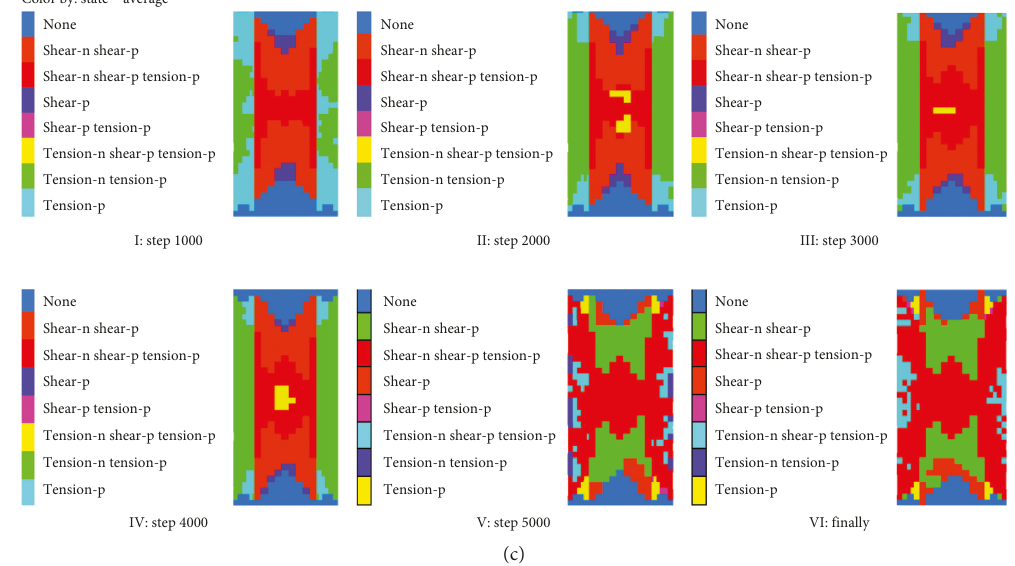
Figure 8: Numerical simulation contour of the loading process of RCTMC specimen. (a) Z -directional stress contour through the point (0, 0, 50) and the normal coordinate is (0, 0, 1). Unit: Pa. (b) Z -directional stress contour of the Z -axis normal profile. Unit: Pa. (c) Z -directional plastic zone contour of the Y -axis normal profile.